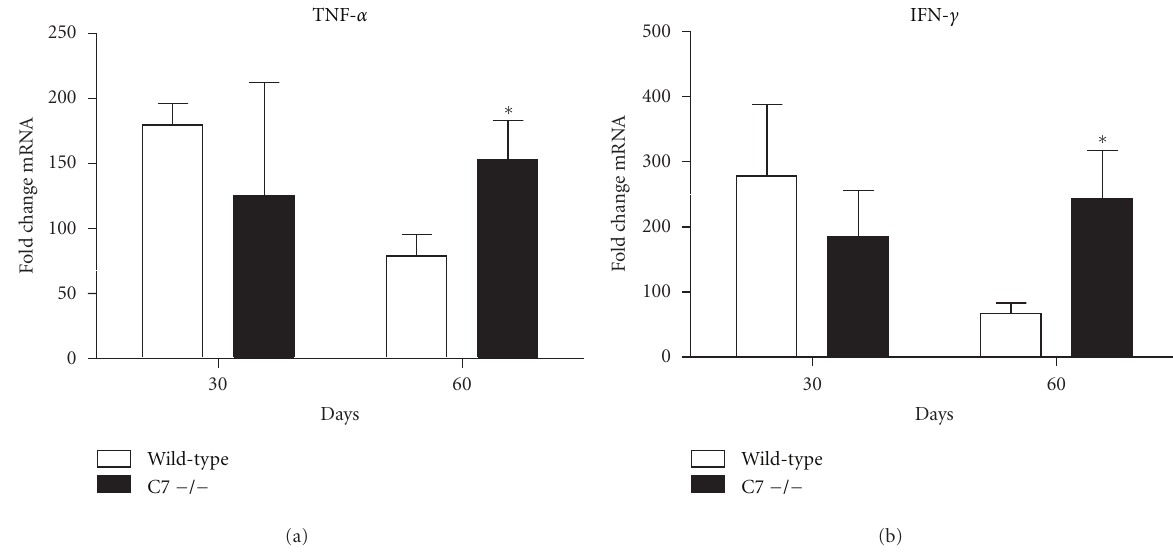
Figure 3: Lung expression of proinflammatory mediators TNF- α and IFN- γ in wild-type and C7 − / − mice. Lung cytokine expression of TNF- α , and IFN- γ as measured by quantitative PCR in wild type (solid bars) and C7 − / − (open bars) mice at 60 days post challenge with virulent MTB. Data are expressed as fold change relative to na¨ıve mice after normalization to β -actin. Data are presented as the mean with SD, n = 6 mice per group, per time point. ∗ P < 0 . 05, comparisons are made to control mice. There were no significant di ff erences in lung expression of IL-6, IL-12p40, TGF- β , or IL-17 (data not shown).